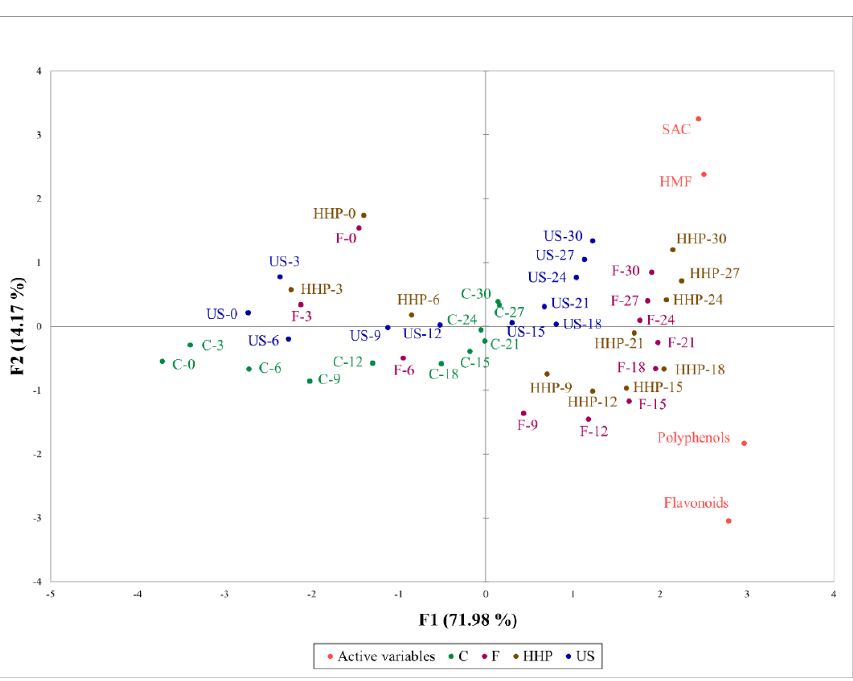
Figure 4. Principal component analysis of functional components of black garlic subjected to differ- ent processes.